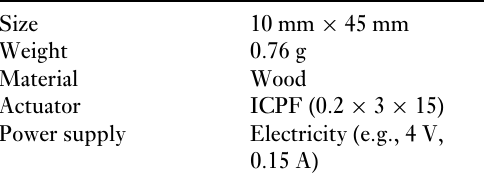
Figure 11 Walking motion underwater. Table 2 Specifications of the prototype